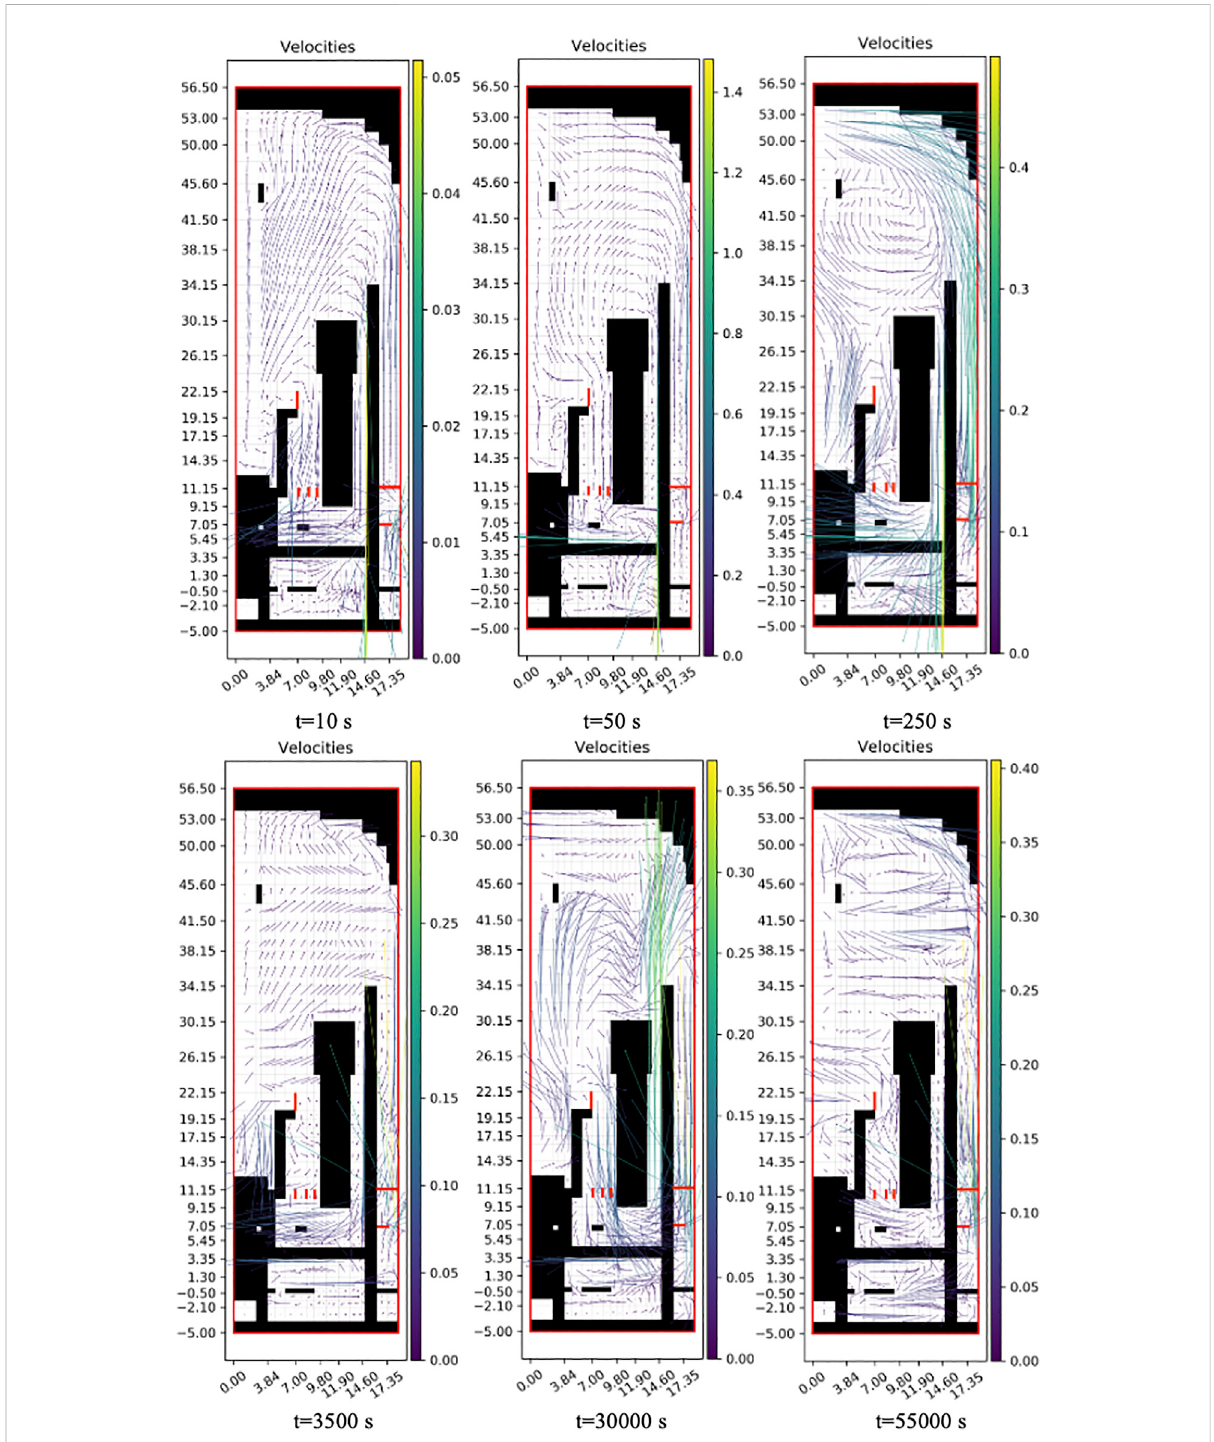
FIGURE 7 Velocity vector distribution in the longitudinal section of SG2